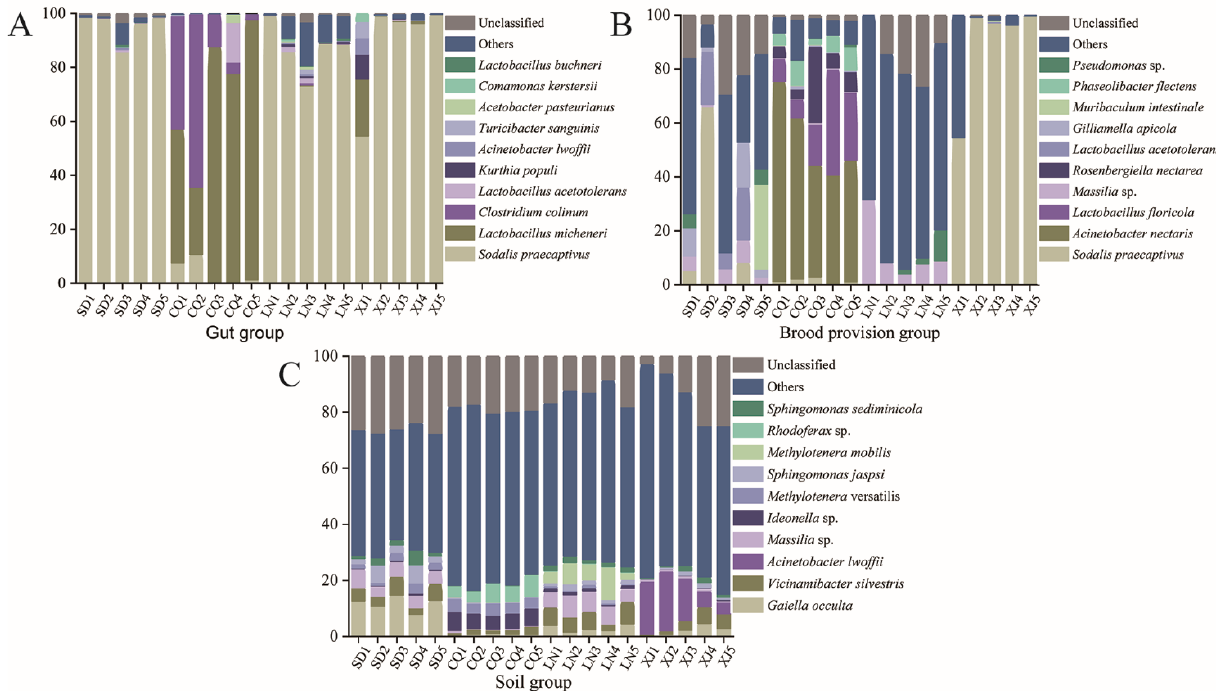
Figure 2. Bacterial community structure and relative abundance in gut ( A ); brood provision ( B ); and nest soil ( C ). The y ‐ axis and x ‐ axis represent the proportional abundance of bacterial OTUs and samples, respectively.